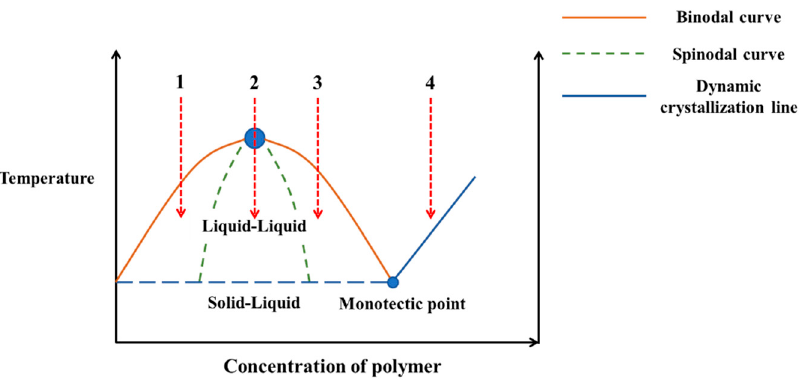
Figure 17. Phase diagram for TIPS method.